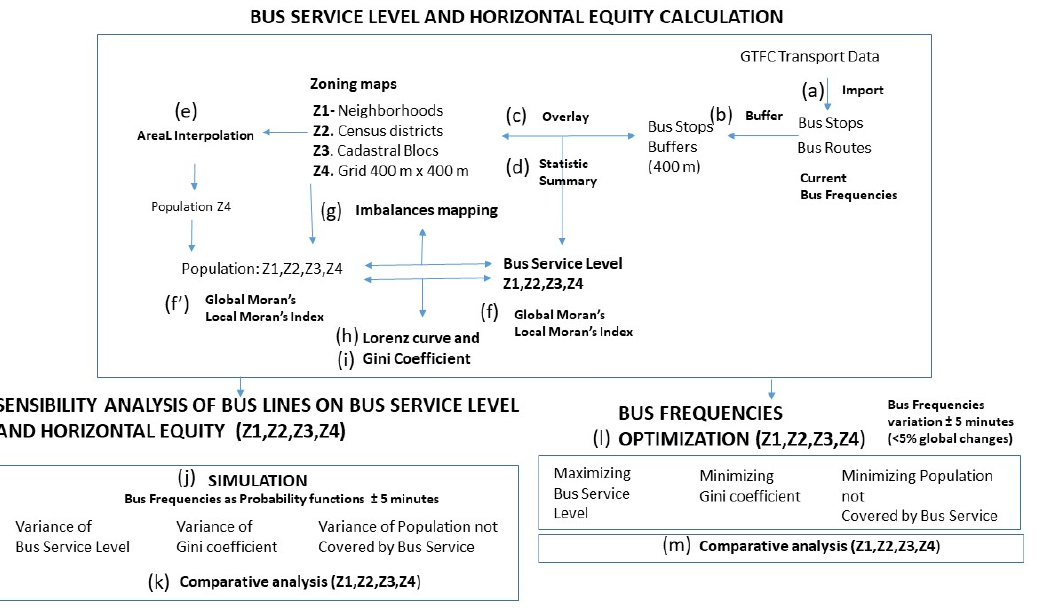
Figure 3. Methodological process.